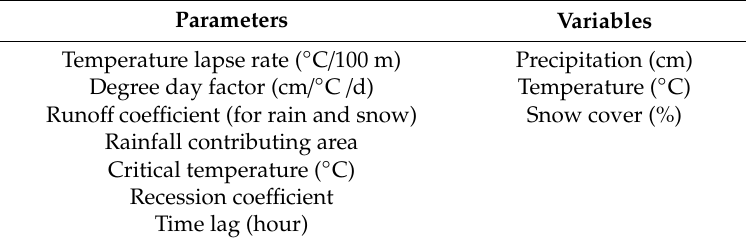
Table 1. Parameters and variables used in the Snowmelt-Runo ff Model